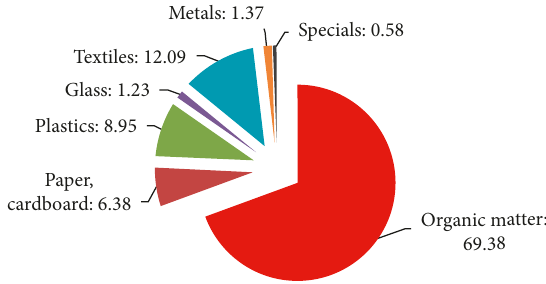
Figure 4: Average physical composition of household and equivalent solid waste in A.E.H. municipality